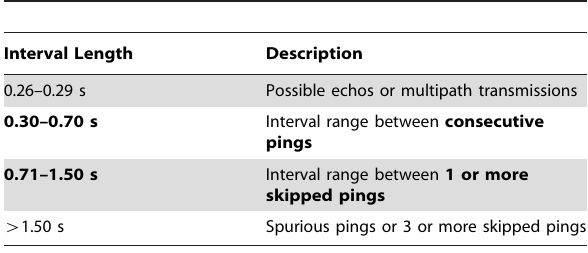
Table 1. Criteria used to determine ping